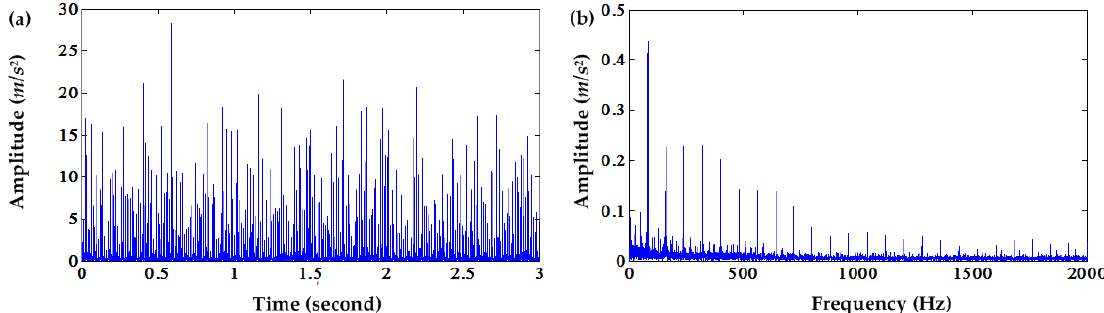
Figure 3. ( a ) Squared envelope signal after the fifth DC offset cancellation; ( b ) squared envelope spectrum after the fifth DC offset cancellation.